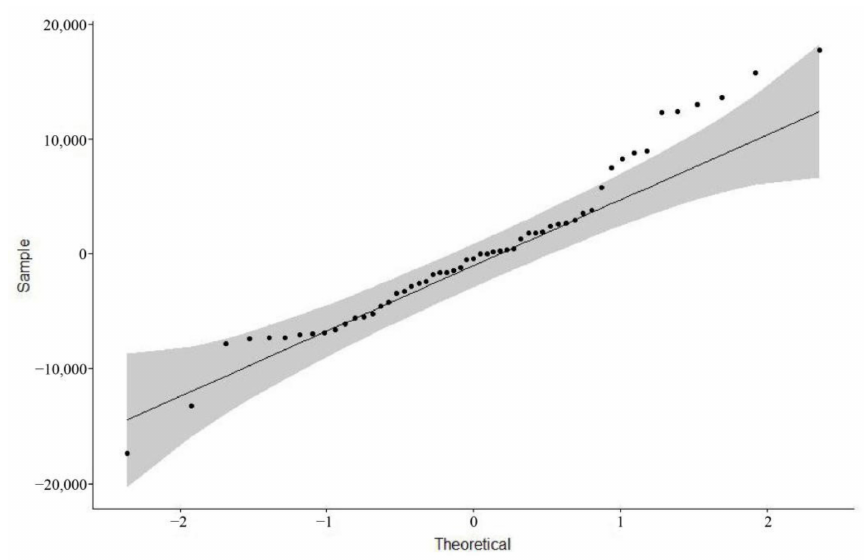
Figure 9. The normal distribution QQ plot of the residuals of the ARIMA ( 0 , 1 , 1 )